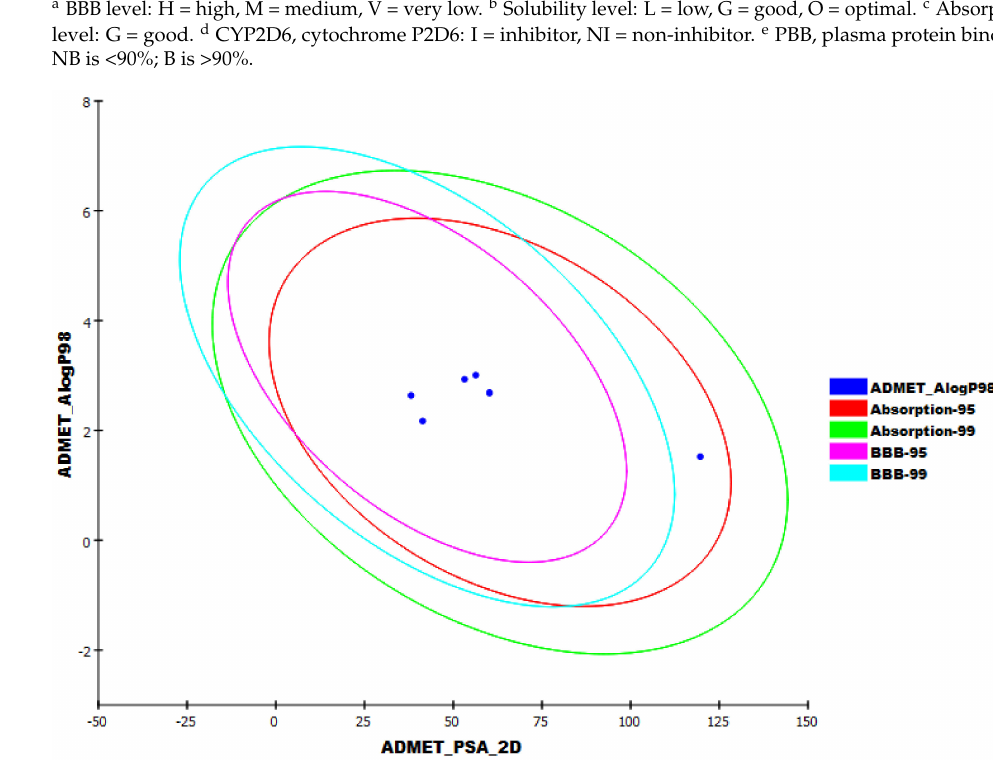
Figure 7. Expected ADMET